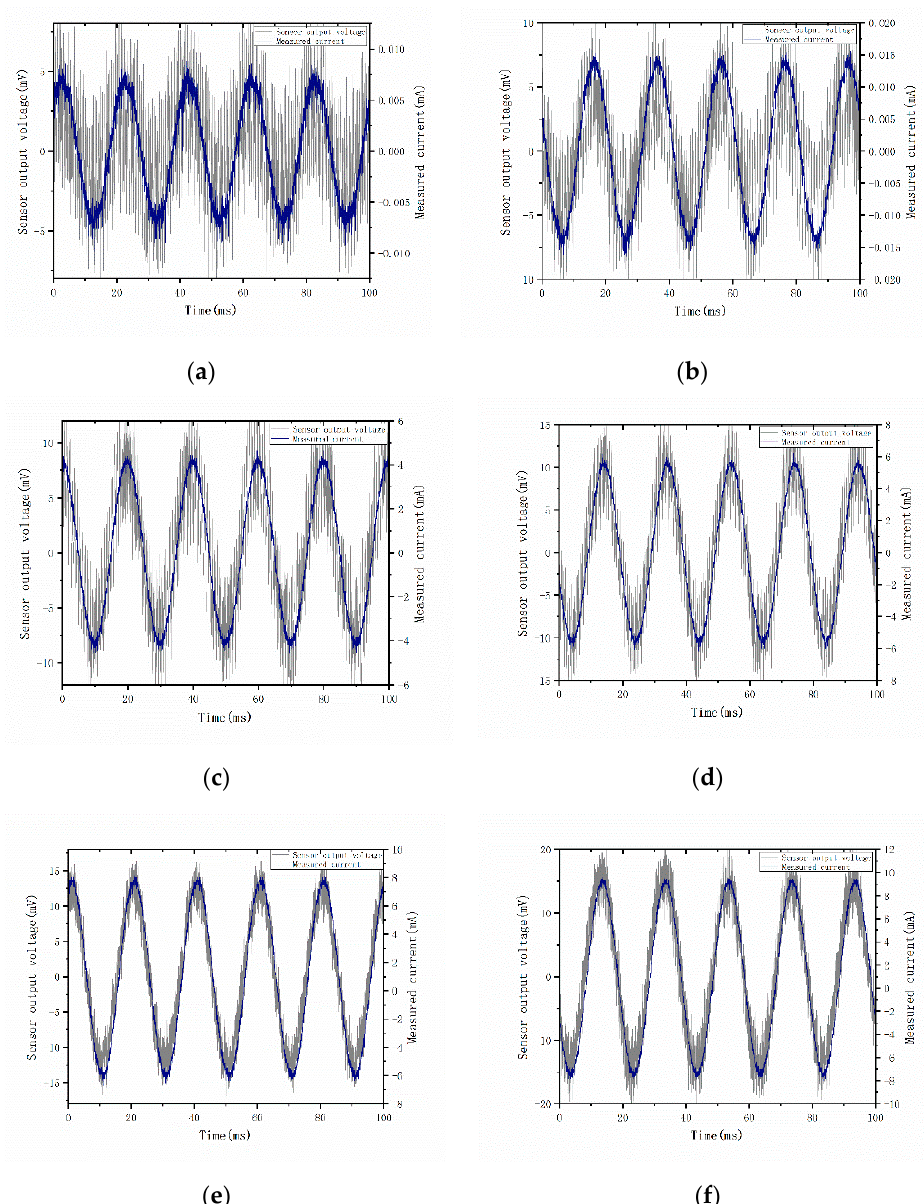
Figure 12. Output waveform at different currents: ( a ) 1 mA; ( b ) 2 mA; ( c ) 3 mA; ( d ) 4 mA; ( e ) 5 mA; and ( f ) 6 mA.